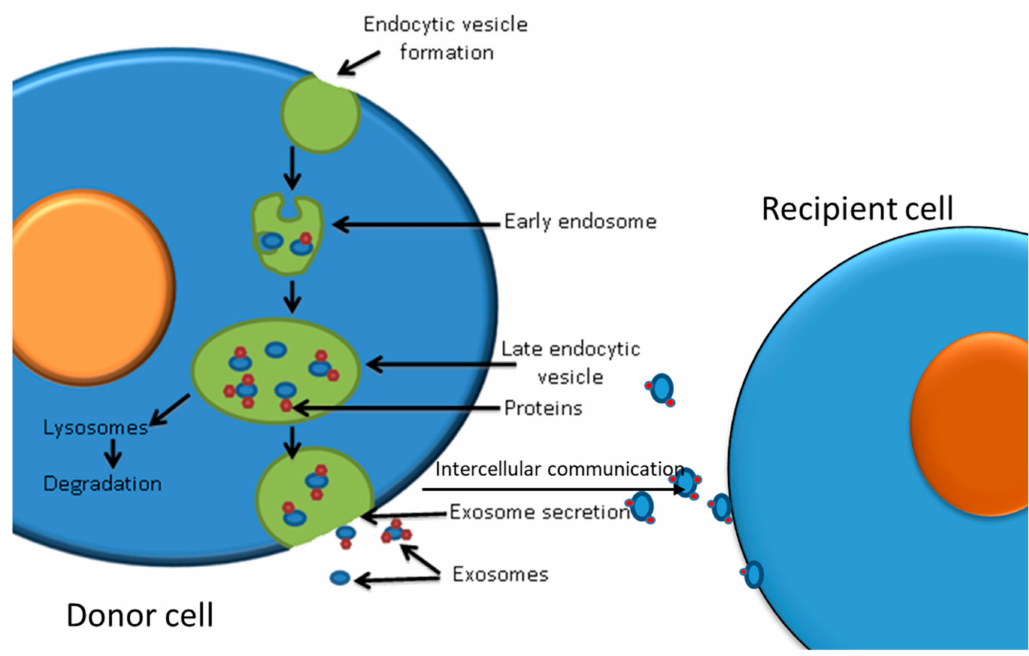
Figure 3. Exosome biogenesis, secretion, and cell communication via